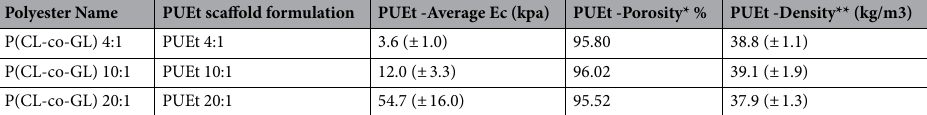
Table 2. A correlation between the polyester triol used in the synthesis of each PUEt scaffold formulation and the compression elastic modulus (Ec), porosity and density. * Measured by means of µCT scan. ** ASTM D3574 – 17: Standard Test Methods for Flexible Cellular Materials—Slab, Bonded, and Molded Urethane